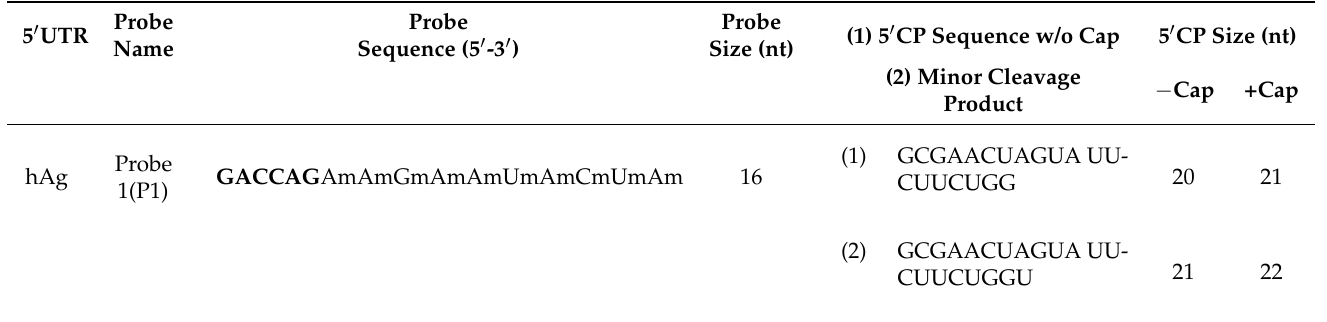
Table 4. RNase H cleavage assay probe and products.